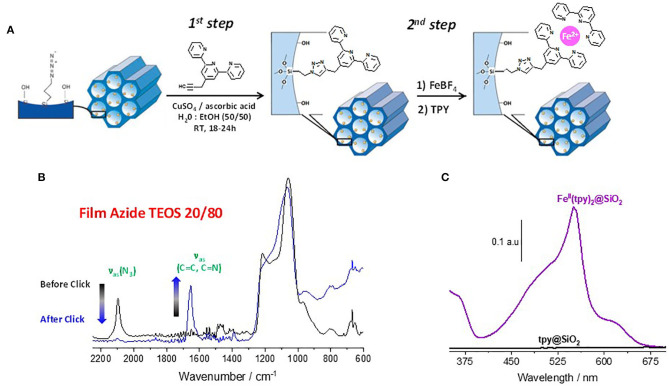
(A) Illustration of the fabrication process of the electrochromic molecular assemblies from azide-functionalized silica thin films. 1st step: preparation of the terpyridine-functionalized silica from azide-functionalized silica films via copper-catalyzed azide-alkyne cycloaddition reaction. 2nd step: Preparation of the Fe(tpy)2-functionalized silica thin films by coordination of the tridentate nitrogen-based ligands with Fe2+ and additional terpyridine ligands. (B) Click reaction monitored by infrared spectroscopy. (C) Fe(tpy)2 complex formation monitored by UV-Vis spectroscopy.